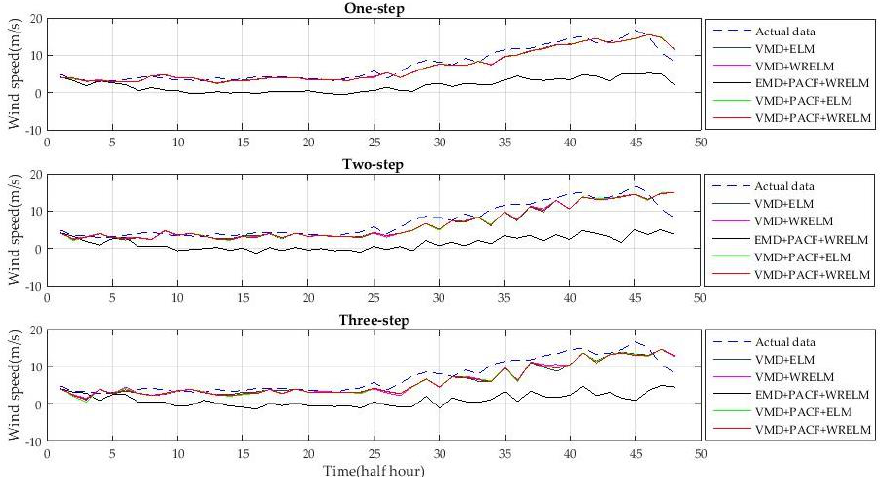
Figure 12. Forecasting results on 20 May 2004, using different methods. Energies 2016 , 9 , 989 16 of 20